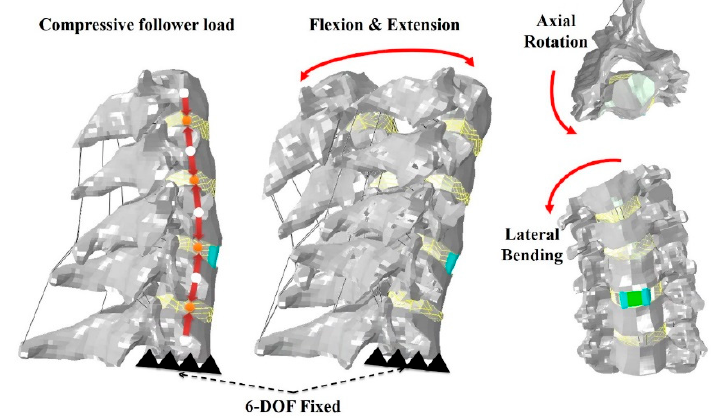
Figure 1. Design of allograft spacers. Length and position of allograft spacers. ( A ) Anterior cortical bite positioning of allograft spacers ( B ) Types of allograft spacers: CO, cortical only; CC, cortico- cancellous; CLC, cortical lateral walls with a cancellous center bone, in that order. ( C ) Schema of the nutcracker mechanism upon flexion and extension in anterior cortical bite positioning of allograft spacers.